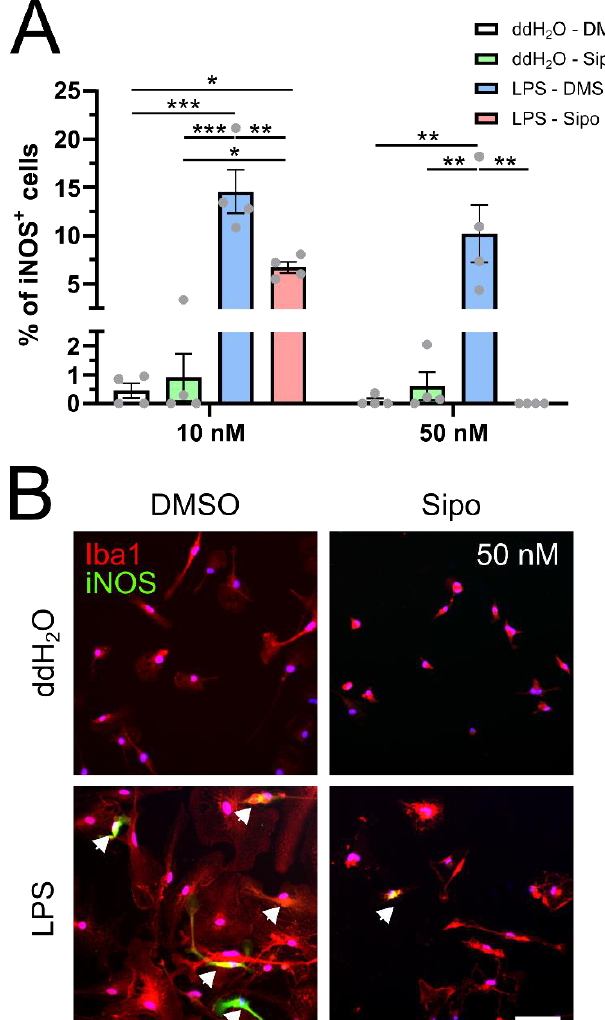
Figure 2. Siponimod reduces microglial iNOS protein expression in an inflammatory milieu. ( A ) Quantification of the percentage of iNOS positive microglia after 3 days of stimulation with +/− 10/50 µM siponimod +/− LPS. ( B ) Representative images of Iba1, iNOS co staining after stimulation for 3 days with +/− 50 µM siponimod +/− LPS. Data are presented as mean values ± SEM. Grey dots represent individual data points and white arrows point to iNOS positive microglia. Significance was assessed by 1-way analysis of variance (ANOVA) followed by Tukey’s post hoc test using Graph-Pad Prism 8.4.3 (GraphPad Software, San Diego, CA, USA). The experimental groups were considered significantly different at * p < 0.05, ** p < 0.01, *** p < 0.001. Scale bar: 50 µ